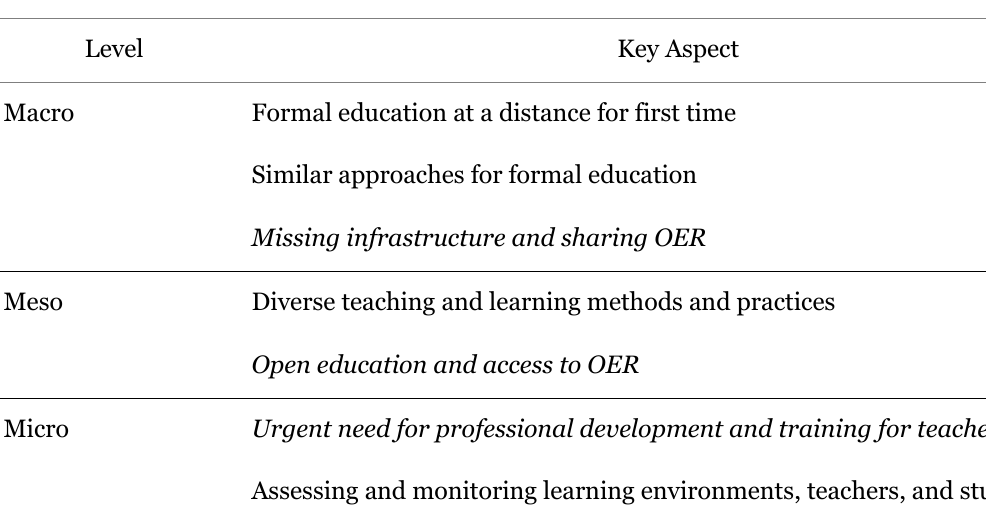
Key Aspects of Distance Education Due to COVID-19 in 13 Countries